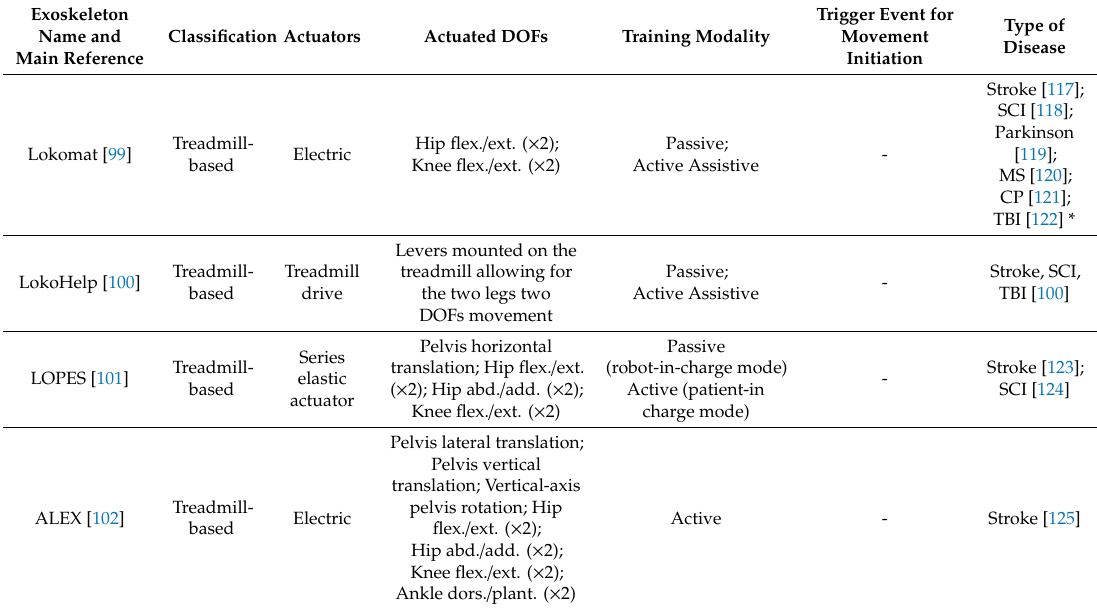
Table 4. Main features of the most common lower limbs